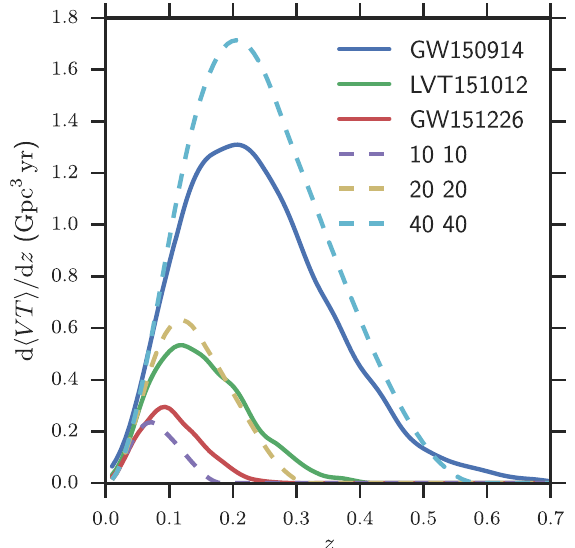
FIG. 14. The rate at which sensitive space-time volume accumulates with redshift. Curves labeled by component masses in M ⊙ are computed using an approximate prescription described in Ref. [42], assuming sources with fixed masses in the comoving frame and with zero component spins; the GW150914, GW151226, and LVT151012 curves are determined from the Monte Carlo injection campaign described in Sec. z ≈ 0 . 2 , with the search being sensitive to some signals with redshifts as high as 0.6.